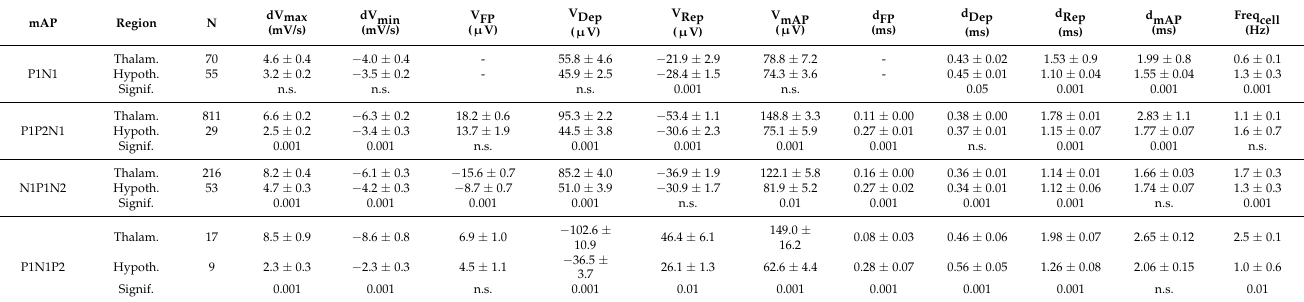
Table 3. Comparison between thalamic cells (obtained from a previous work) and hypothalamic